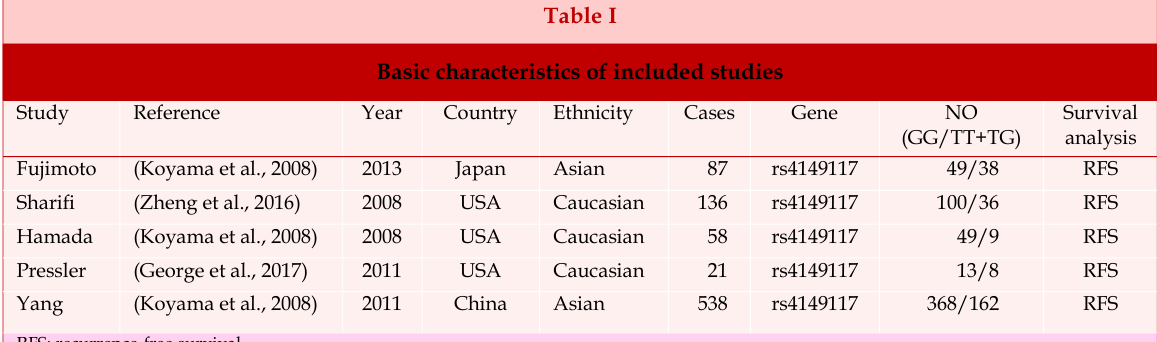
Basic characteristics of included studies